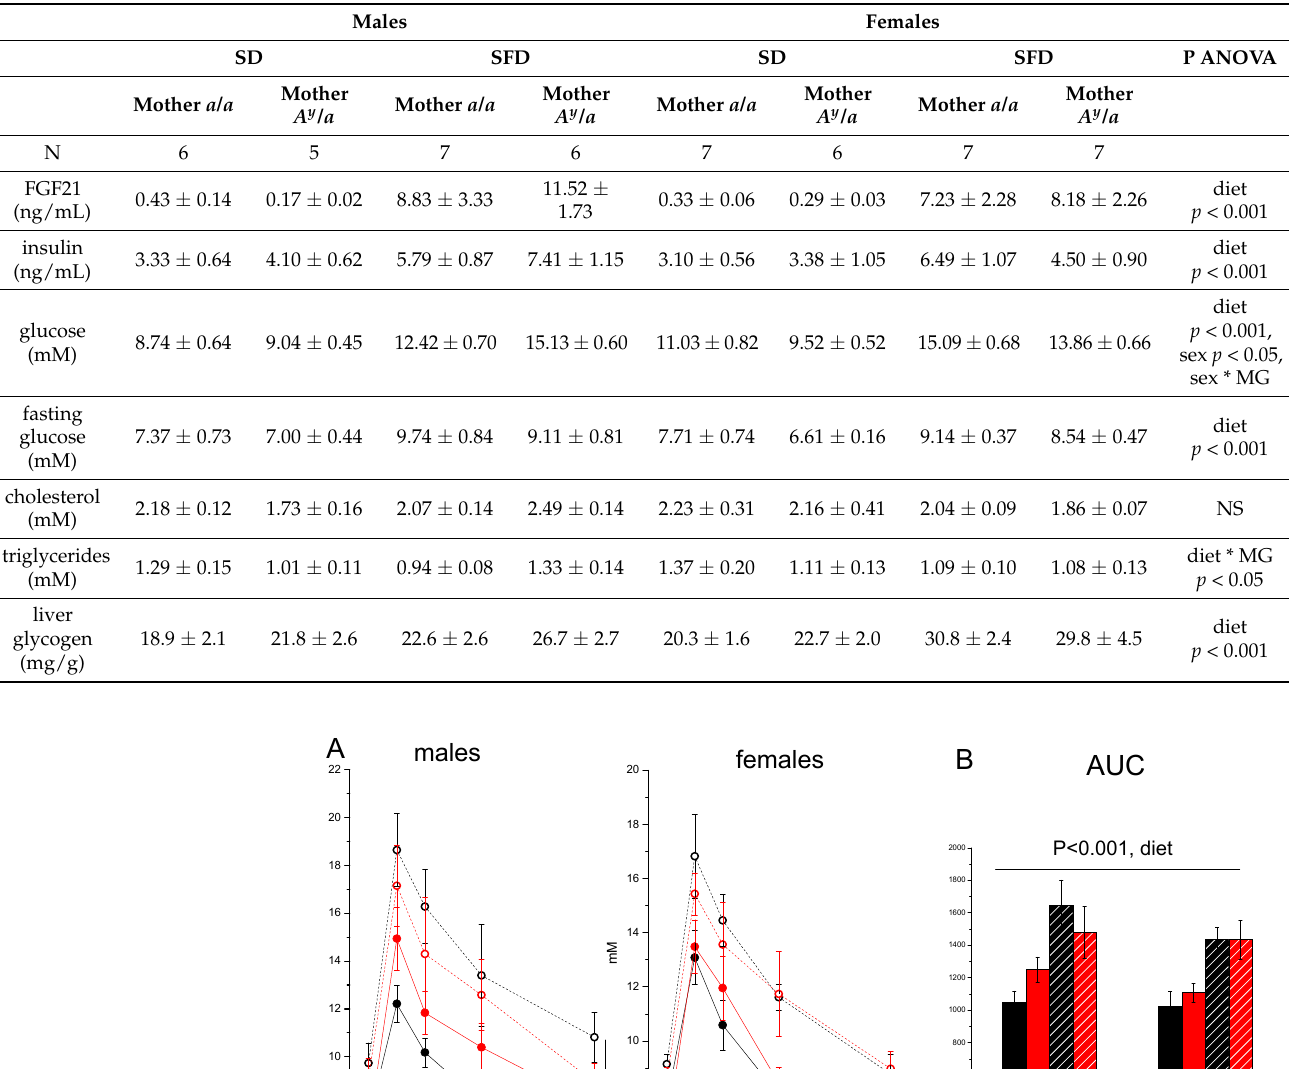
Table 3. Hormonal and metabolic characteristics in male and female offspring of control and obese mothers on a standard diet and sweet and fatty diet.